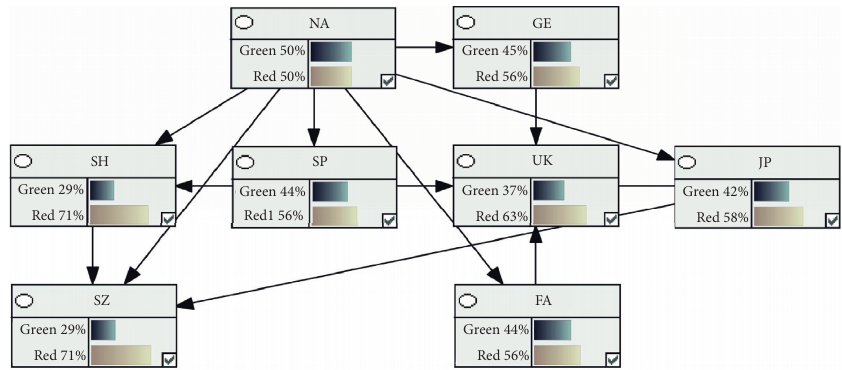
Figure 3: BN initial state diagram (NA).